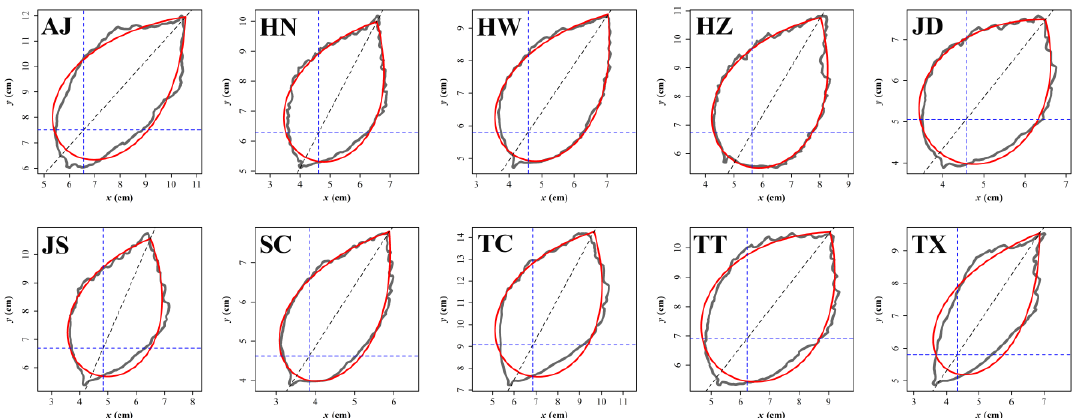
Figure 5. Fitted results using the SGE for the 10 geographical populations of P. subaequalis . AJ: Anji, Zhejiang Province; HN: Xinyang, Henan Province; HW: Huangwei, Yuexi, Anhui Province; HZ: Changhua, Huangzhou, Zhejiang Province; JD: Jingde, Anhui Province; JS: Yixing, Jiangsu Province; SC: Shucheng, Anhui Province; TC: Tongcheng, Anhui Province; TT: Tiantangzhai, Jinzhai, Anhui Province; TX: Tianxia, Yuexi, Anhui Province. For every panel, the gray curve represents the scanned (observed) leaf edge, and the red curve represents the leaf edge predicted by the SGE. The leaves correspond to those in Figure 3.